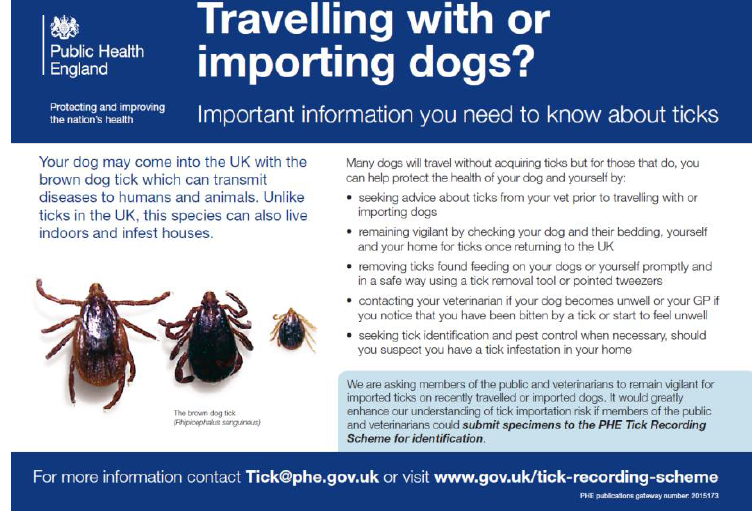
Figure 7. Raising awareness of risks associated with native, and, in this case, non-native ticks.